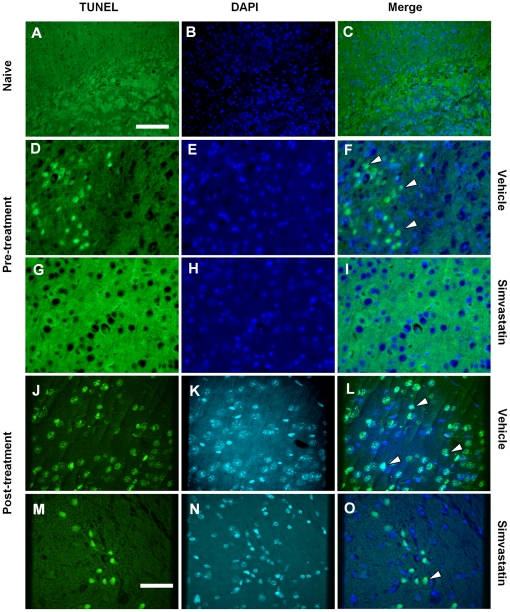
Simvastatin reduces TUNEL positive cells after SAH.Representative images shown are from cerebral cortex. Vehicle-treated animals show numerous TUNEL positive cells (F and L, arrow heads). In comparison, there are fewer positive cells in post-SAH simvastatin treated animals (O, arrow heads), and almost no positive TUNEL positive cells in the pre-treatment mice (I), none in naïve mice (C). Scale bars are 200 µm in A to C, 50 µm in D to O.